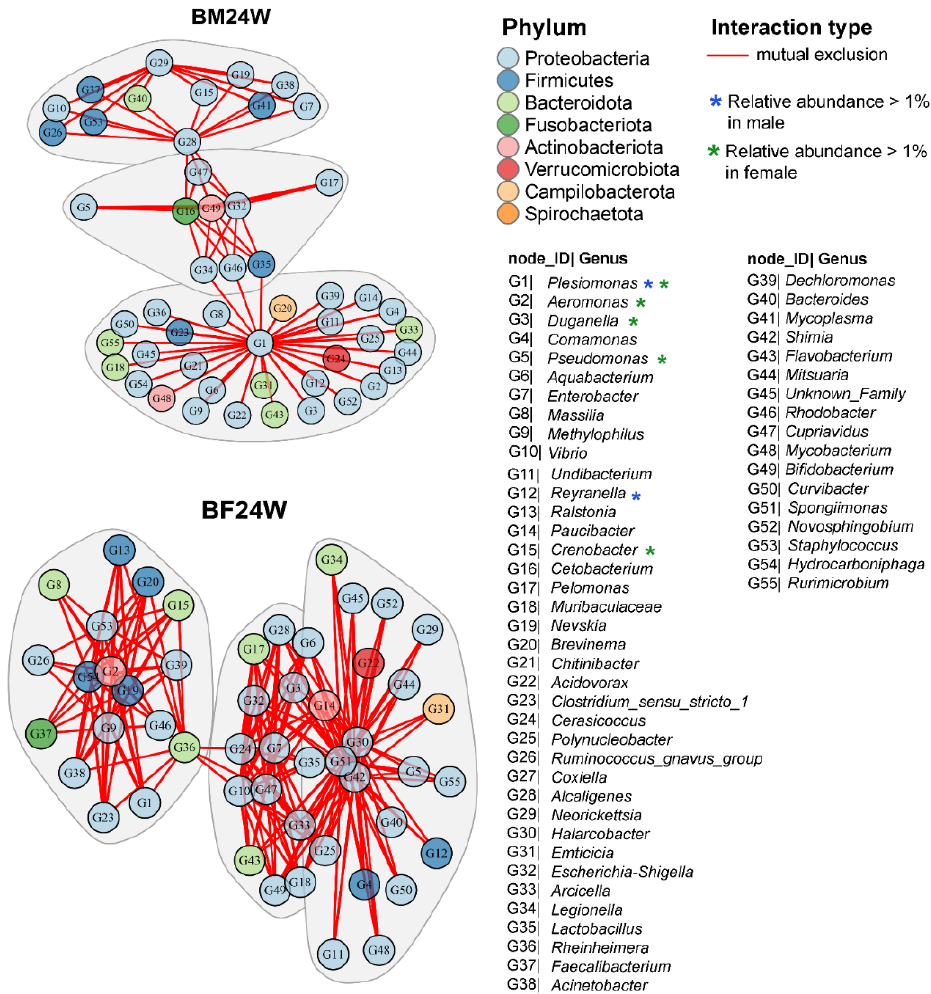
Figure 5. Microbiota co-occurrence network graphs at the genus level in 24-week-old Siamese fighting fish. The Spearman correlation coefficient was used to calculate network interactions between gut microbiota. The cutoff for a significant correlation was 0.8 ( q < 0.05, multiple testing corrections using the Benjamini-Hochberg method). The presence of red edges indicates mutual exclusion (negative correlation). The colors of the nodes represent the phylum level. Gray shades are used to color each module. Bacterial genera are represented by node IDs. The minimum row occurrence was set to one (suggested by the CoNet app). BM24W, 24-week-old male Siamese fighting fish; BF24W, 24-week-old female Siamese fighting